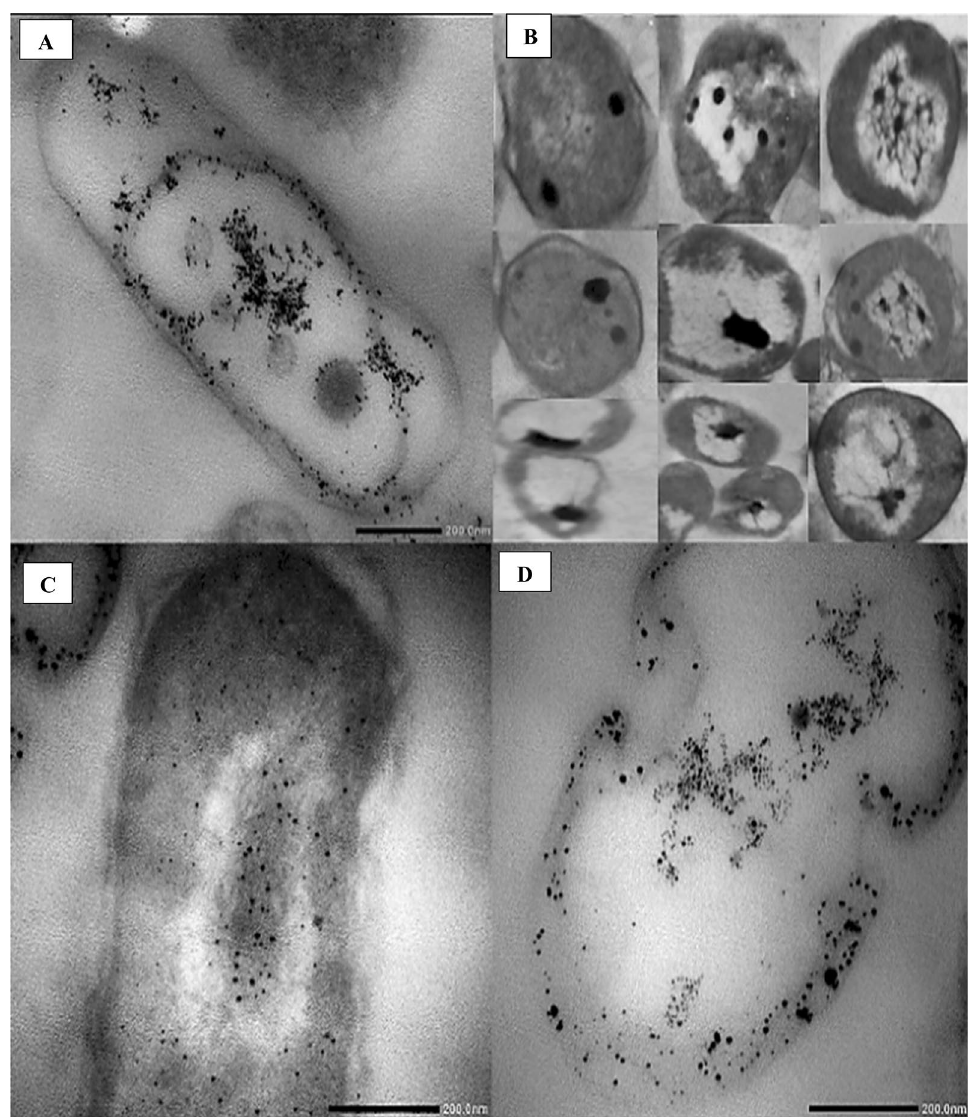
Figure 5. Intracellular biosynthesis of metals NPs, FeNPs in Pseudomonas putida ( A ), CuNPs in Enterococcus thailandicus ( B ), CoNPs in Marinobacter hydrocarbonoclasticus ( C ), and ZnNPs in P. geniculata isolate ( D